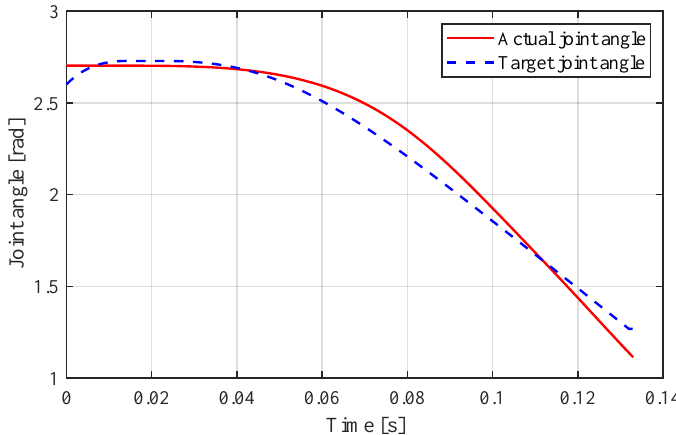
Figure 15. Joint angle of experiment.